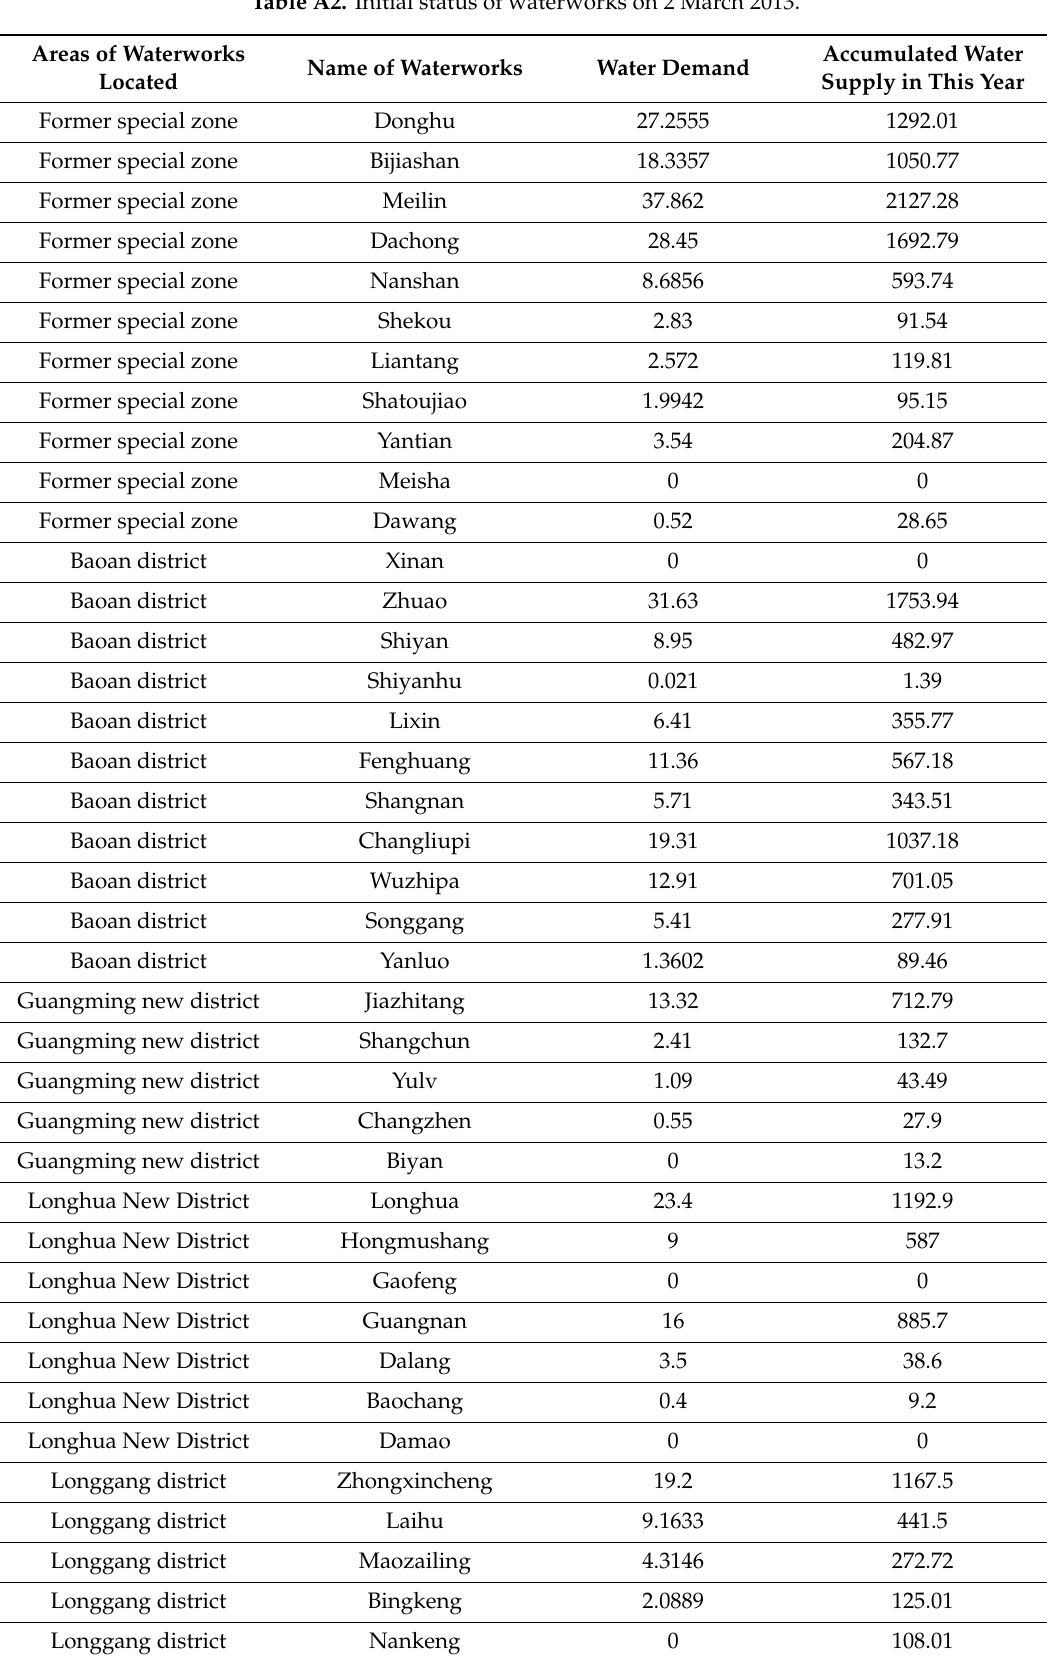
Table A2. Initial status of waterworks on 2 March